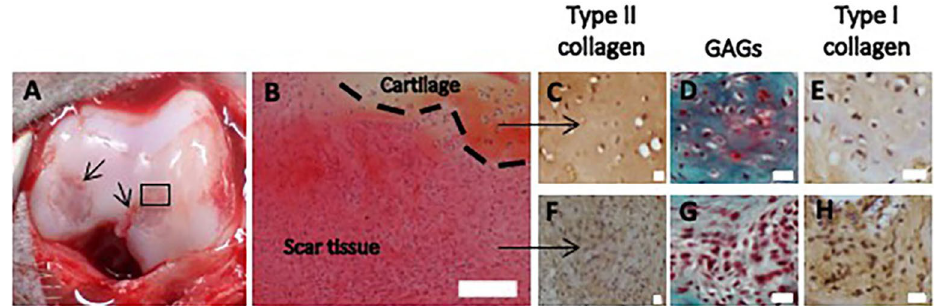
Figure 2. Representative macroscopic image ( A ) and histological sections ( B – H ) of scar tissue and native cartilage observed at day 0, before debridement of the defects. ( A ) The small arrows indicate the edges of the defects. The square refers to the histological section in ( B ). ( B ) Hematoxylin and eosin staining of the border of the defect. The dotted line indicates the interface zone between scar tissue and native cartilage (scale bar: 200 μm). ( C – E ) and ( F – H ) depict detailed regions of cartilage and scar tissue, respectively, with staining of GAGs and immunostaining of type I and type II collagen, as indicated (scale bar: 20